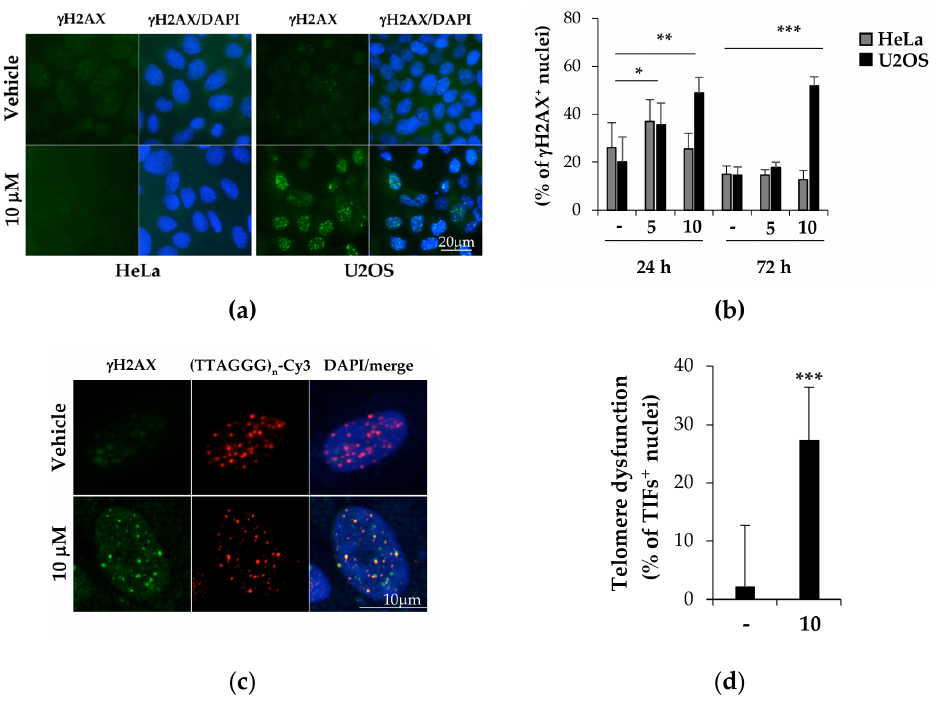
Figure 9. TERRA binding by BPBA triggers persistent DDR and telomere dysfunction in U2OS cells. HeLa and U2OS cells treated with indicated doses of BPBA . At each endpoint, cells were fixed and processed for immunofluorescence with the antiphosphorylated γ H2AX mAb primary antibody, followed by goat–antimouse 488 secondary antibody ( a , b ) alone or ( c , d ) in combination with FISH using the telomere-specific (TTAGGG) n -Cy3 PNA probe. Fluorescence signals acquired with a Leica DMIRE deconvolution microscope (representative images at 72 h shown in ( a )) or a Zeiss LMS confocal scanner ( b ) at 63 × magnification. Percentage of cells displaying γ H2AX signals or TIFs (>4 (TTAGGG) n -Cy3/ γ H2AX colocalizing spots) was scored and reported in histograms (( b , d ), respectively). Histograms report the mean of at least 6 different fields per sample ( n > 150). Error bars are SD; * = p < 0.5; ** = p < 0.1; *** = p < 0.05.